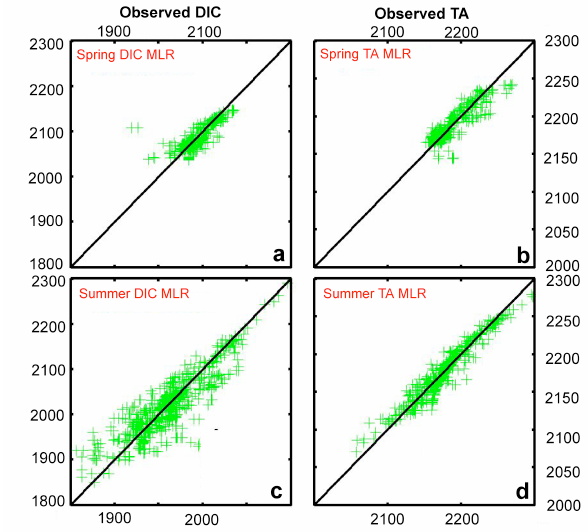
Fig. 4. (a) Interpolation of observed DIC using MLR approaches Figure 4 . a . Interpolation of observed DIC using MLR approaches for the 2008 spring BEST for the 2008 spring BEST cruise (std.dev 12.7µmoleskg − 1 ; r 2 = cruise (std.dev 12.7 µ moles kg -1 ; r 2 = 0.63; n = 368); b . Interpolation of observed TA using 0.63; n = 368); (b) Interpolation of observed TA using MLR ap- MLR approaches for the 2008 spring BEST cruise (std.dev 8.4 µ moles kg -1 ; r 2 = 0.78; n = proaches for the 2008 spring BEST cruise (std.dev 8.4µmoleskg − 1 ; 368); c Interpolation of observed DIC using MLR approaches for the 2008 summer BEST r 2 = 0 . 78; n = 368); (c) Interpolation of observed DIC using cruise (std.dev 27.9 µ moles kg -1 ; r 2 = 0.76; n = 582); d . Interpolation of observed TA using MLR approaches for the 2008 summer BEST cruise (std.dev MLR approaches for the 2008 summer BEST cruise (std.dev 6.7 µ moles kg -1 ; r 2 = 0.92; n = 27.9µmoleskg − 1 ; r 2 = 0.76; n = 582); (d) Interpolation of ob- served TA using MLR approaches for the 2008 summer BEST 582). cruise (std.dev 6.7µmoleskg − 1 ; r 2 = 0 . 92; n =